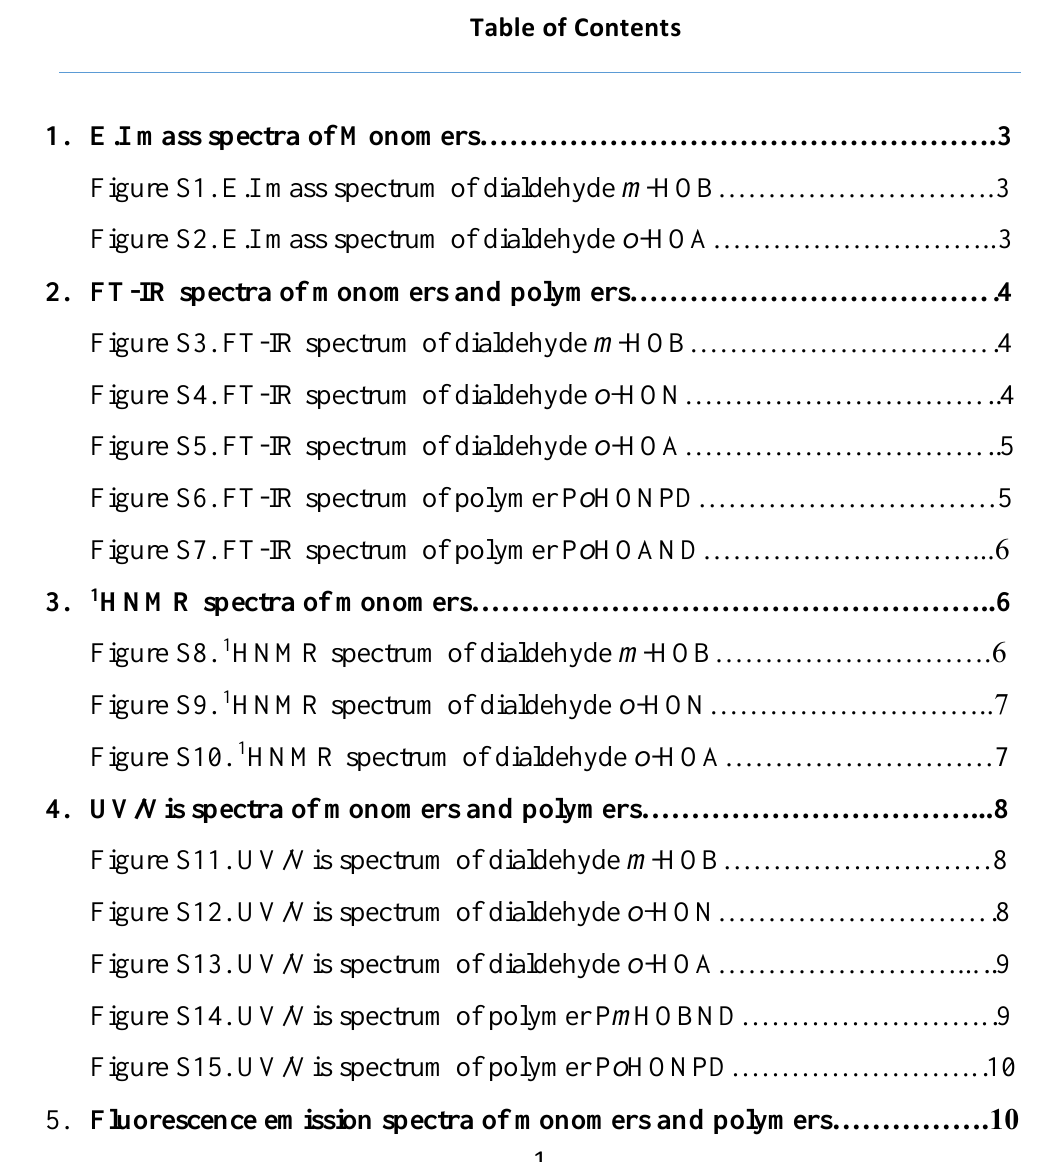
Figure S2. E.I mass spectrum of dialdehyde o -HOA………………………..3 2. FT-IR spectra of monomers and polymers……………………………….4 Figure S3. FT-IR spectrum of dialdehyde m -HOB………………………….4 Figure S4. FT-IR spectrum of dialdehyde o- HON…………………………..4 Figure S5. FT-IR spectrum of dialdehyde o -HOA…………………………..5 Figure S6. FT-IR spectrum of polymer P o HONPD…………………………5 Figure S7. FT-IR spectrum of polymer P o HOAND………………………...6 3. 1 HNMR spectra of monomers……………………………………………..6 Figure S8. 1 HNMR spectrum of dialdehyde m -HOB……………………….6 Figure S9. 1 HNMR spectrum of dialdehyde o -HON………………………..7 Figure S10. 1 HNMR spectrum of dialdehyde o -HOA………………………7 4. UV/Vis spectra of monomers and polymers……………………………...8 Figure S11. UV/Vis spectrum of dialdehyde m -HOB………………………8 Figure S12. UV/Vis spectrum of dialdehyde o- HON……………………….8 Figure S13. UV/Vis spectrum of dialdehyde o -HOA…………………….....9 Figure S14. UV/Vis spectrum of polymer P m HOBND……………………..9 Figure S15. UV/Vis spectrum of polymer P o HONPD……………………..10 5. Fluorescence emission spectra of monomers and